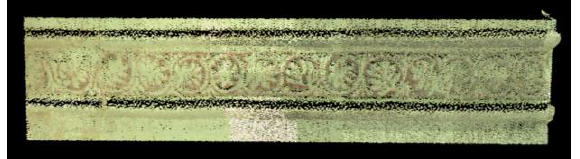
Figure 15. The 3-D plaster point cloud.